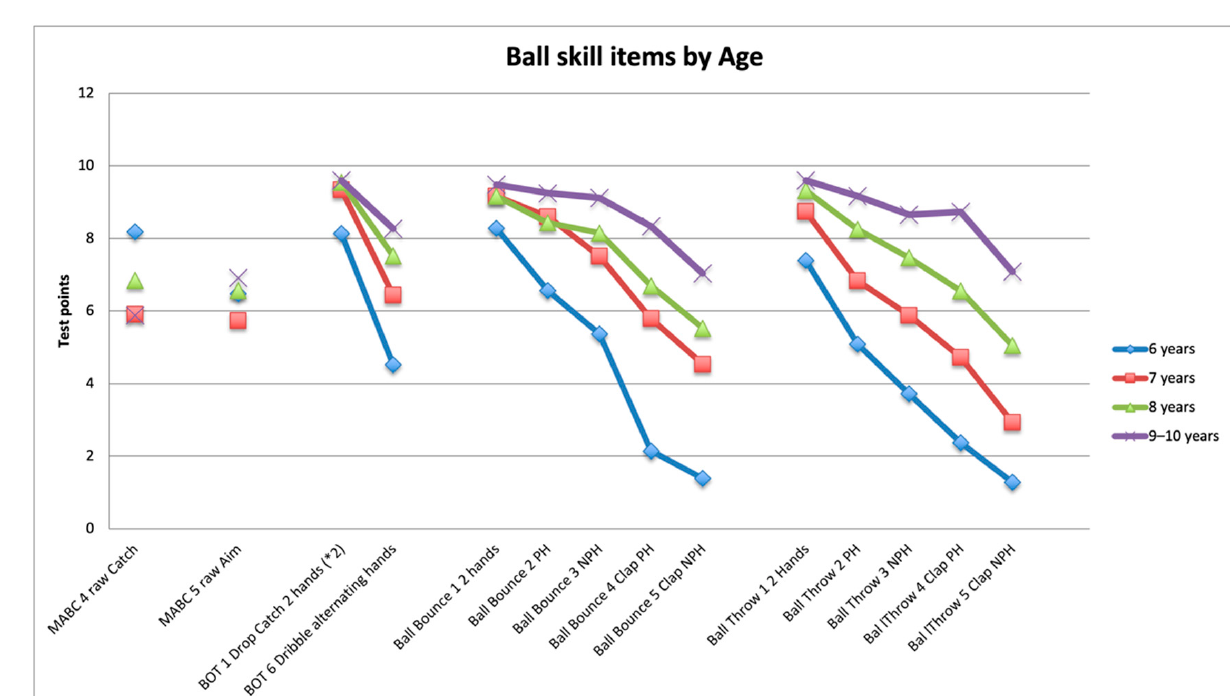
Figure 2. Ball skill items by age. Items of the standardized tests for all 250 children are shown on the x -axis, while mean score per age group on those items is depicted on the y -axis. The maximum score for all items is 10. PH = preferred hand; NPH = non-preferred hand.